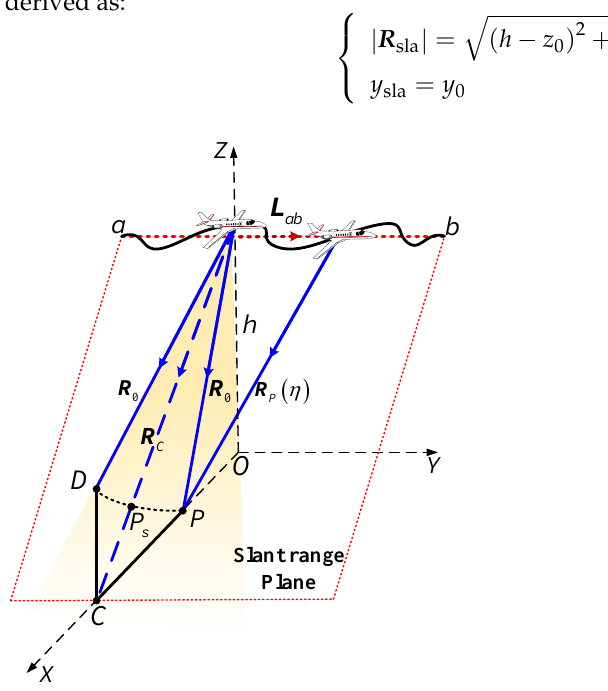
Figure 5. Geometry model of slave imaging focusing.